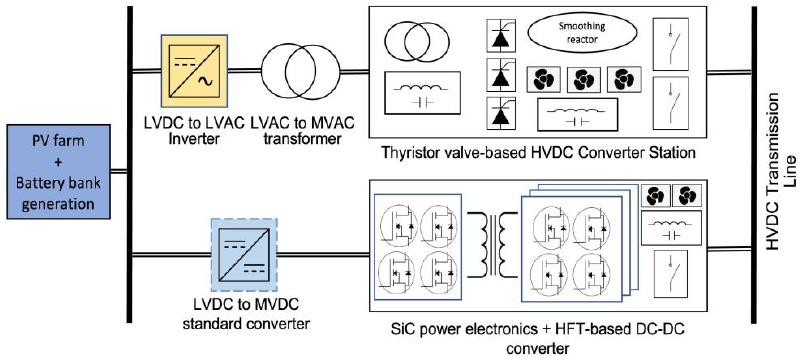
Figure 5. Existing HVDC transmission systems with the AC grid vs. proposed HVDC network with high-efficiency DC-DC converters.